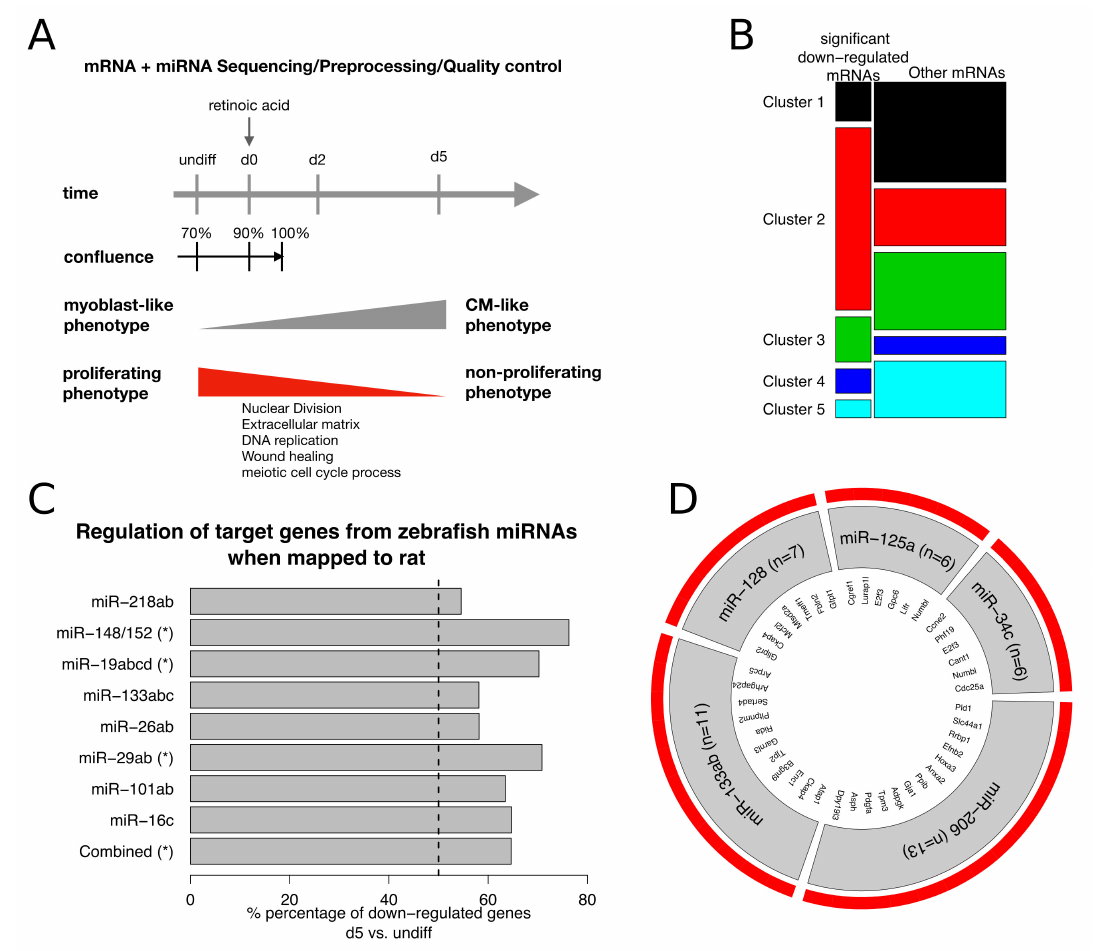
Figure 6. ( A ) Experimental design of the H9c2 cell line. Both mRNA and miRNA were sequenced at 4 different time points that display a differentiation into a CM-like phenotype and a reduction of the proliferative capability. ( B ) Proportions of the significant down-regulated genes (d5 vs. undiff; FDR < 0.01 and log2FC < − 1) and the remaining mRNAs in the H9c2 cells when mapped to zebrafish homologues and their corresponding dynamic cluster in zebrafish heart regeneration. Cluster 2 is significantly overrepresented in the down-regulated genes ( χ 2 p -value < 10 − 15 ). ( C ) Percentage of down-regulated genes in differentiated CM-like cells (rat) when mapped to the target genes of miRNAs that were identified in zebrafish heart regulation. (*) indicates a significant proportion of down-regulated genes ( χ 2 p -value < 0.05). ( D ) Top 5 miRNAs with the most predicted target genes in differentiating H9c2 cells. mRNAs were restricted to rat homologues from the dynamic cluster 2 in zebrafish heart regulation and miRNAs were significantly up-regulated at d5 (FDR <